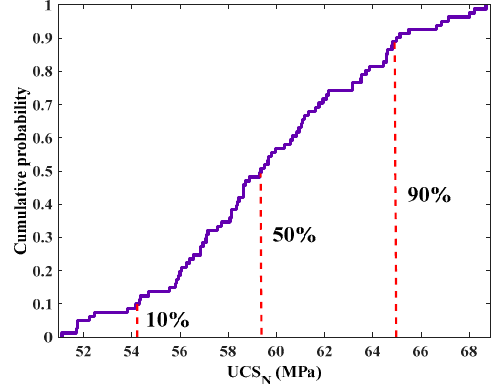
Figure 9. Cumulative probability distribution curve.